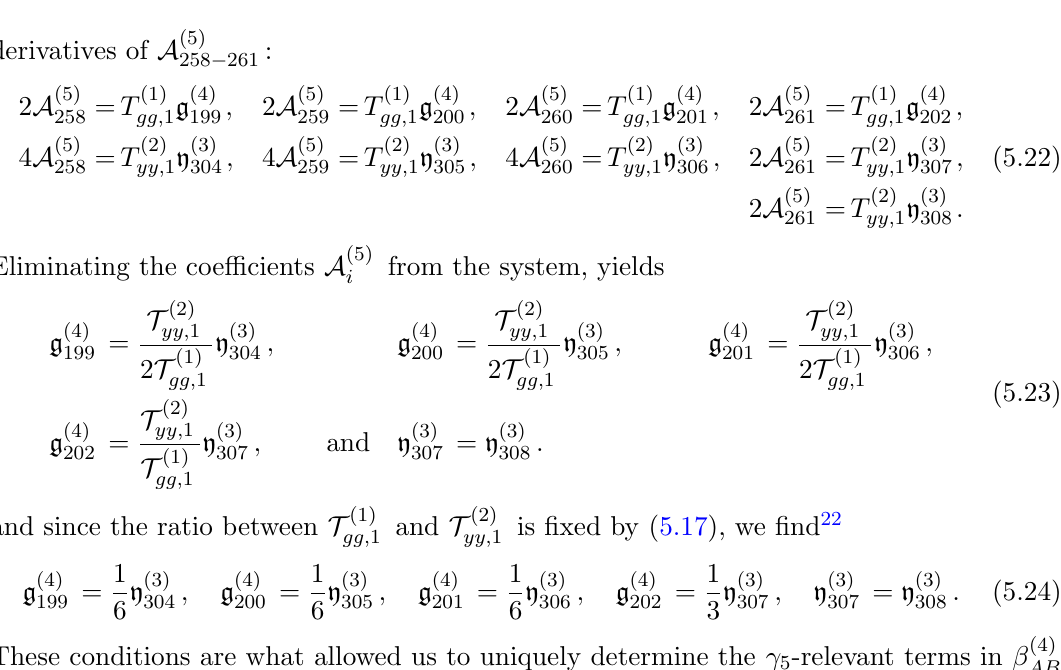
Figure 7 . The (cid:12)rst two rows contains the TSs from non-vanishing (cid:13) while the last row list the 4 corresponding TSs in ~ A (5) . The blobs on the fermion lines symbolize (cid:27) 3